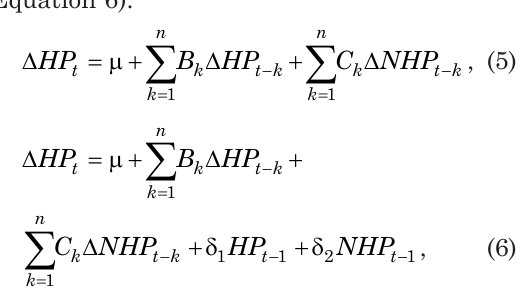
= δ = 0 (no long-run 1 2